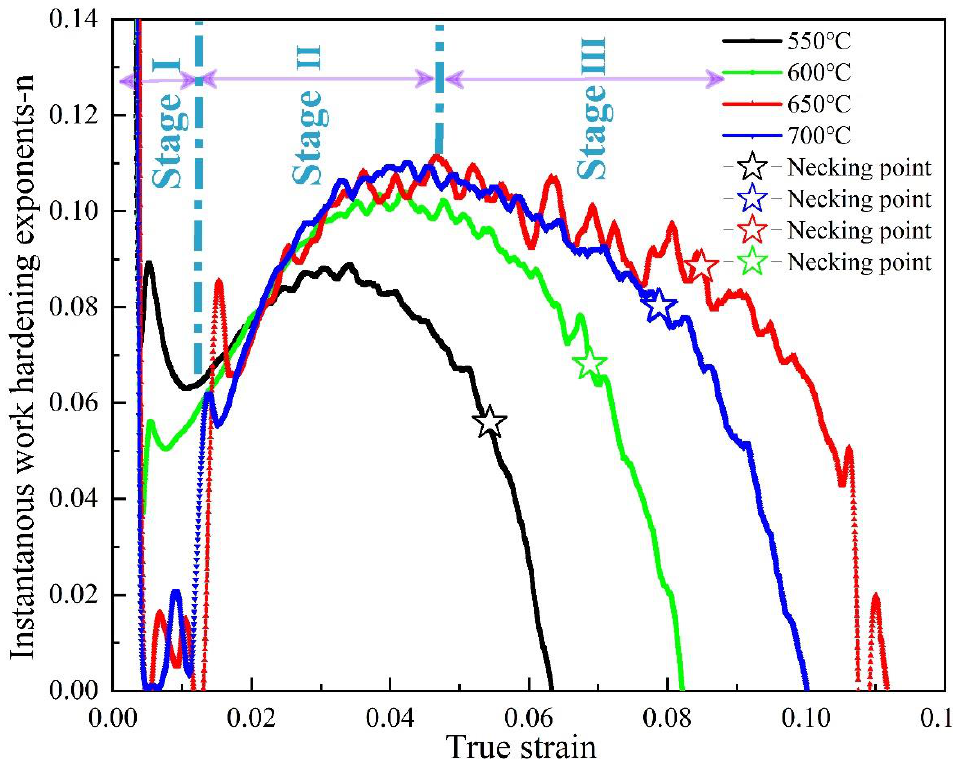
Figure 12. Instantaneous work-hardening exponent, n , as a function of true strain.